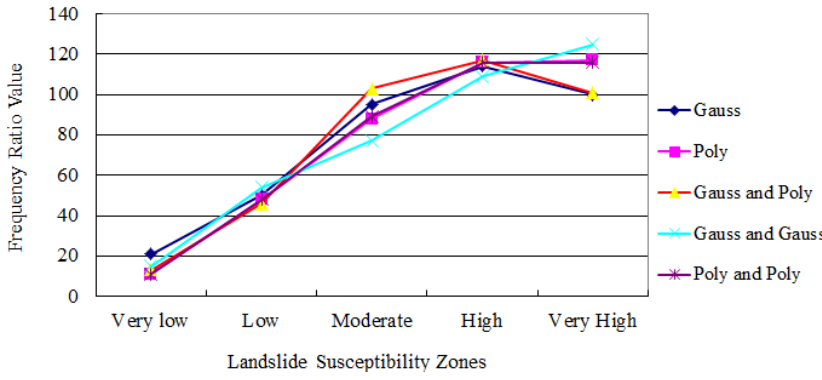
Figure 7. Frequency ratio plots for the five landslide susceptibility zones.